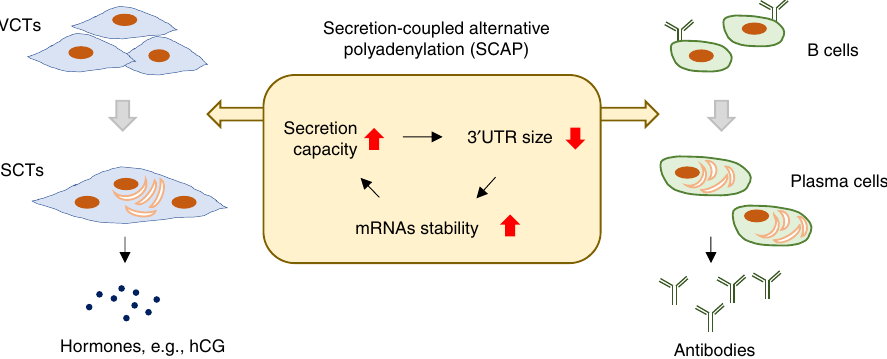
Fig. 8 Secretion-coupled APA (SCAP) in differentiation of secretory cells. SCAP mechanism in SCT differentiation and B-cell differentiation. IPA activation is not shown in